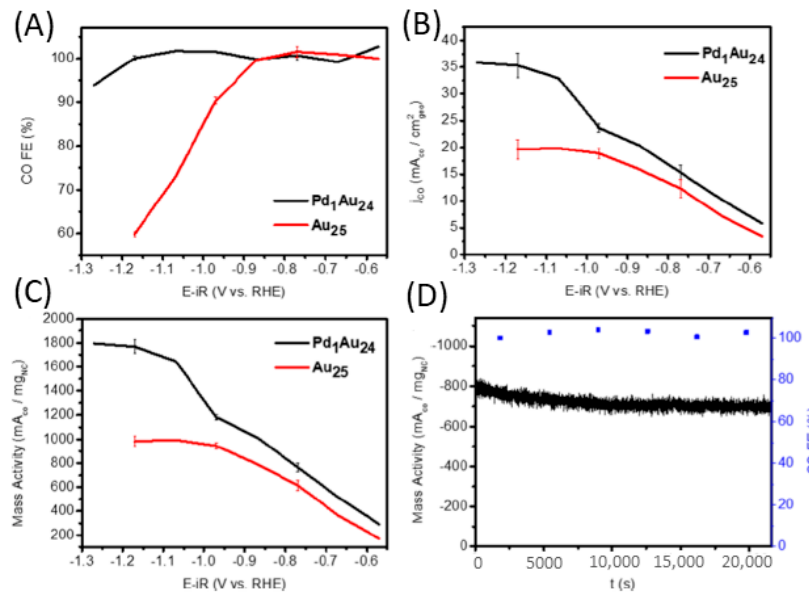
Figure 6. ( A ) FE for CO production. ( B ) CO partial current density. ( C ) CO mass activity. ( D ) Stability test of Pd 1 Au 24 at − 0.8 V for 6 h. Au 25 and Pd 1 Au 24 represent Au 25 (SR) 18 and Au 24 Pd(SR) 18, respectively. Adapted from Reference [58]. Copyright by the American Chemical Society (2020).